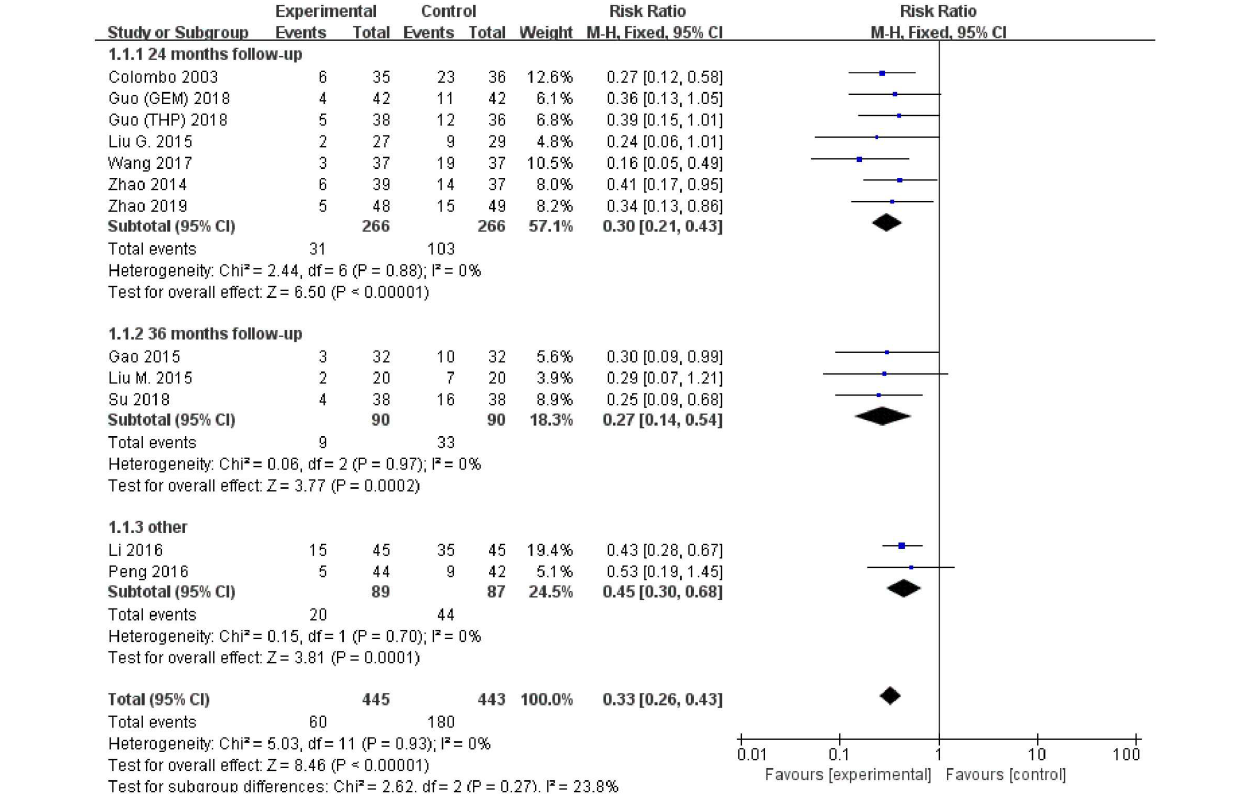
Frontiers in Oncology |